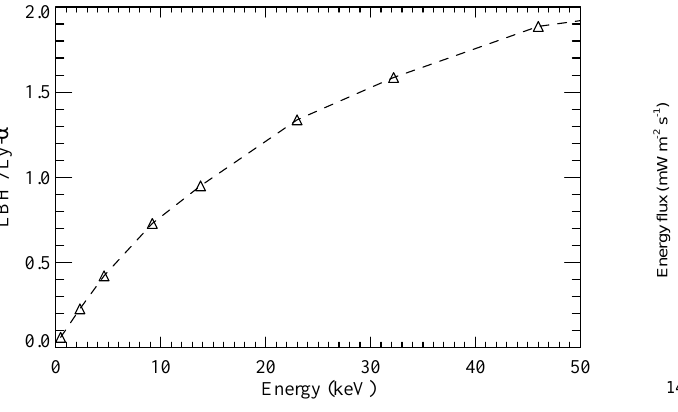
Fig. 2. Variation of the N 2 LBH bands/Ly- α intensity ratio as a function of the mean initial energy of the protons. The curve was calculated for a kappa energy distribution and a nadir observation from outside the atmosphere.